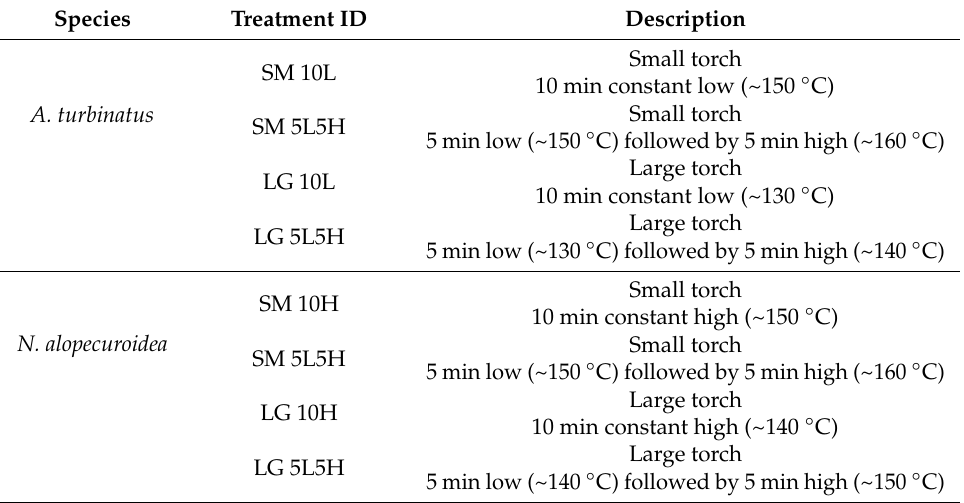
Table 2. A summarised description of the four di ff erent flaming treatments performed for each Amphipogon turbinatus and Neurachne alopecuroidea